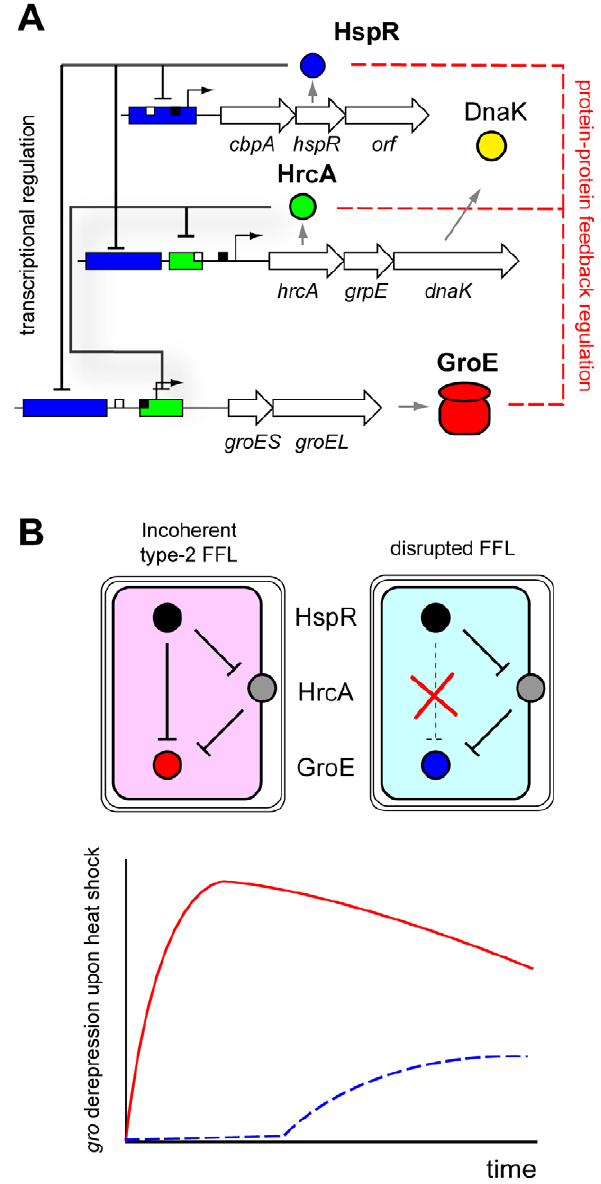
Figure 2. The heat shock and stress response origon. A . The heat shock origon is composed of two TFs (HspR and HrcA) repressing directly three main target operons: I) the cbp operon, encoding, respectively, a DnaJ-homologue CbpA, the HspR regulator itself, and a gene product of unknown function with homology to a helicase (HP1026); II) the hrcA operon, coding for the HrcA regulator, DnaK, and the GrpE co-chaperone; and III) the groESL operon, encoding conserved GroES and GroEL chaperones. Block arrows: open reading frames. Green boxes: HrcA operators; blue boxes, HspR operators. 2 10 and 2 35 boxes are depicted by black and white squares, respectively. TF–DNA interactions and direct transcriptional control are depicted by black lines; red dotted lines represent protein–protein interactions important for feedback control of the circuit; arrowheads denote positive regulation; hammerheads indicate negative regulation. B . Incoherent type-2 FFL wiring of HspR, HrcA, and the groESL operon, responsible for the prompt derepression kinetics of P gro upon heat shock. Red line: derepression kinetic of the intact FFL motif; blue dotted line: derepression kinetic of a mutated P gro promoter in which the HspR operator has been deleted. The membrane association of HrcA in H. pylori [47] may confer additional sensory potential to the circuit,